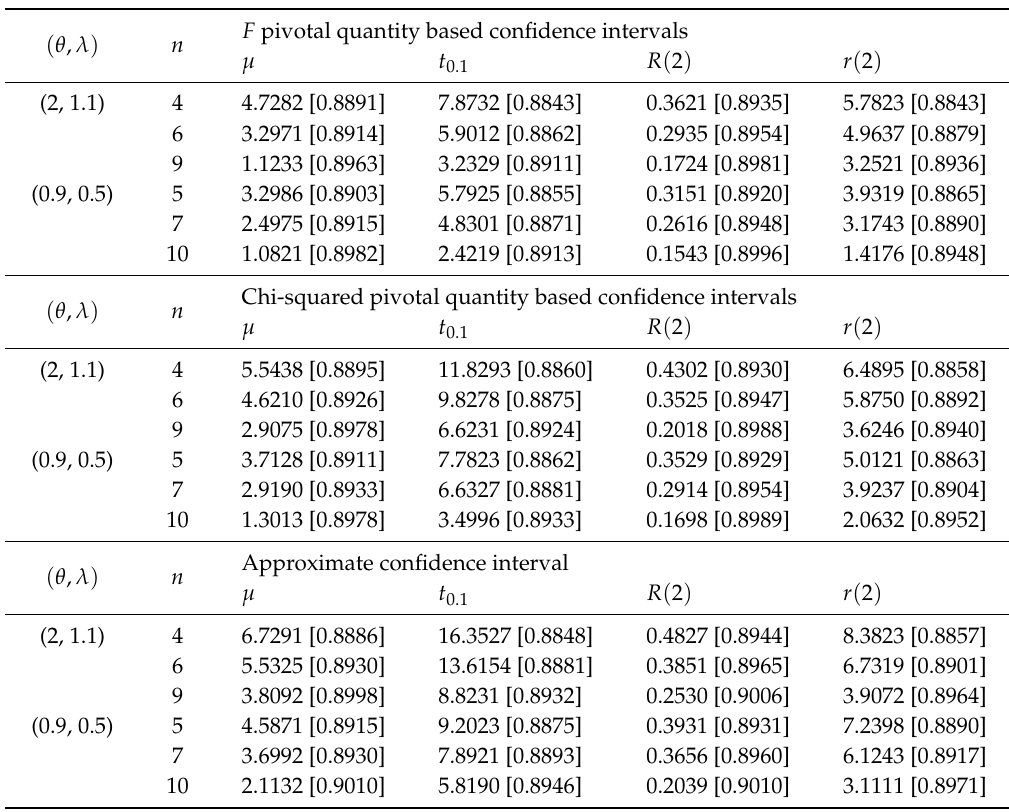
Table 2. AWs and CPs (within bracket) of interval estimates for other indices from